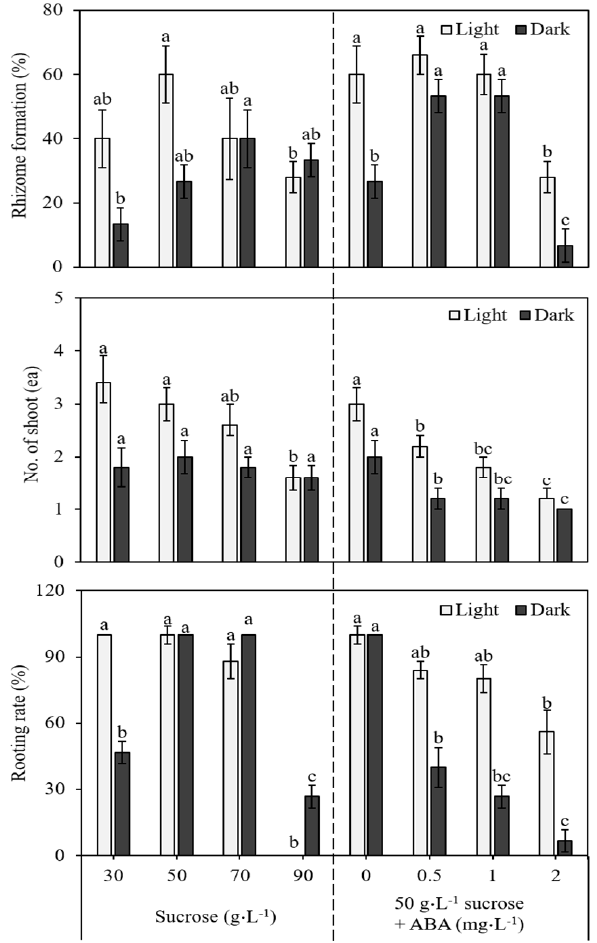
Figure 5. Effect of sucrose and ABA on rhizome induction of Cnidium officinale and under the same treatment (light vs. dark). Different letters in each bar significantly differ from each other as per DMRT ( p < 0.05).